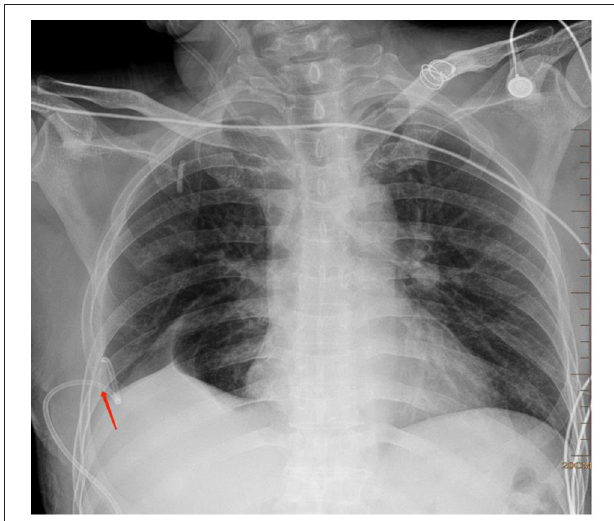
FIGURE 4 | A pigtail catheter was inserted into chest for pneumothorax (red arrow).